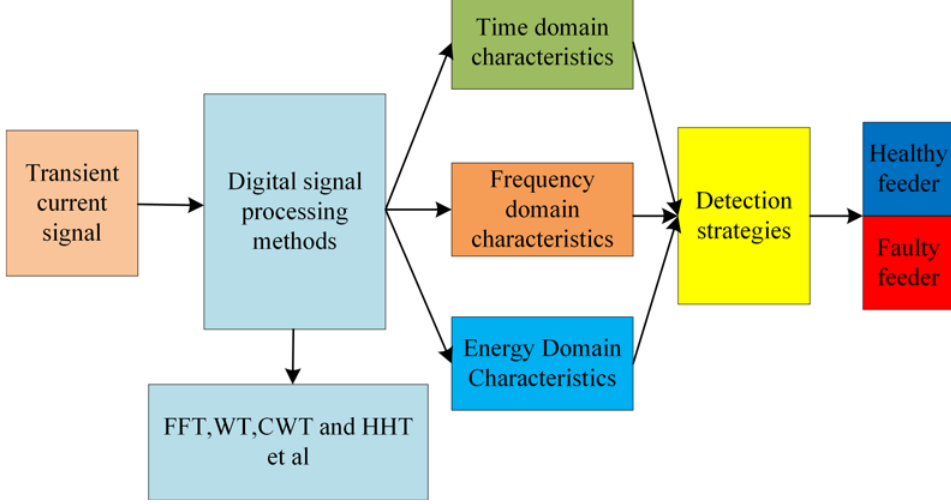
Figure 1. Flow chart of Option 1. If it is a faulty feeder, the output label is ‘1′; otherwise, the output label is ‘0′.